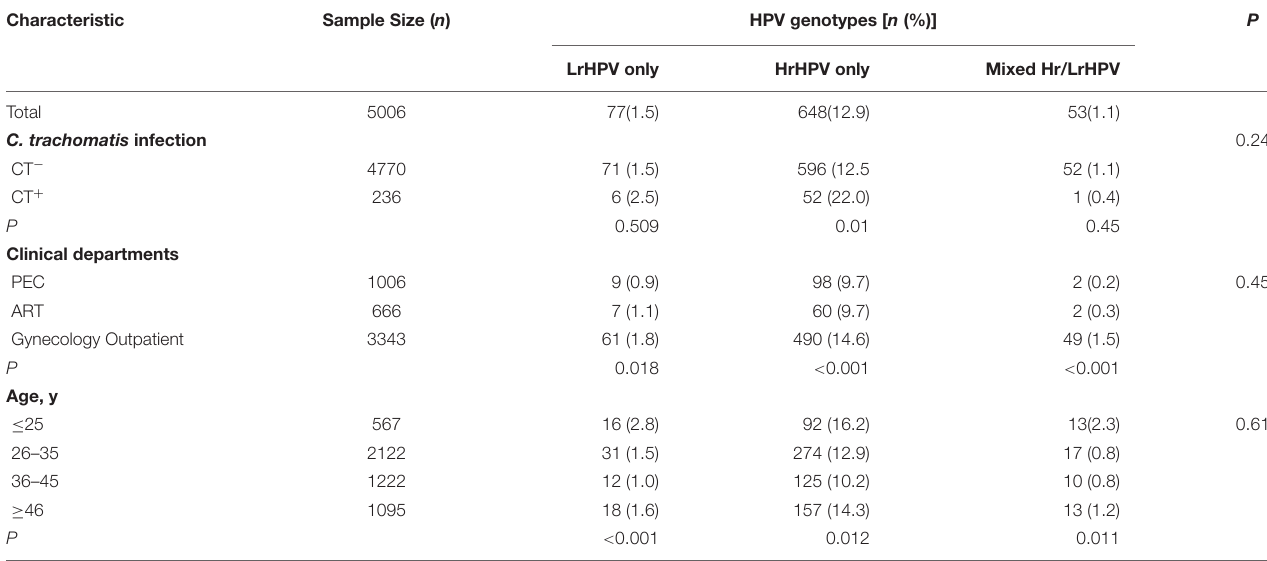
TABLE 4 | Prevalence of low-risk and high-risk of HPV genotypes in 5023 women by C. trachomatis positivity, clinical departments and ages.